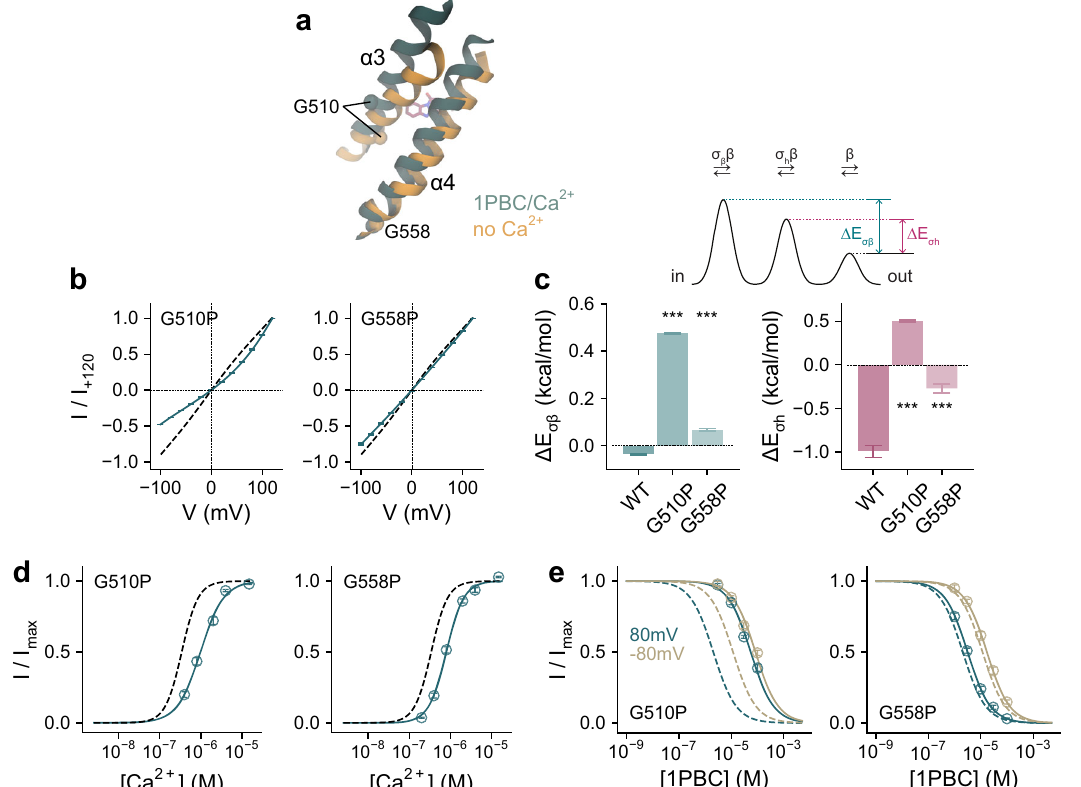
Fig. 8 Functional characterization of conformational changes. a Section of the pore in the superposed 1PBC/Ca 2 + -bound and the rebuilt Ca 2 + -free apo structures viewed from within the membrane. Spheres show C α of Gly 510 and Gly 558 on α 3 and α 4 respectively. b Instantaneous current-voltage relations of the indicated mutants at a saturating Ca 2 + concentration (15 and 50 µ M respectively). Data are averages of 5 and 6 biological replicates for G510P and G558P respectively, errors are SEM. Solid lines are fi ts of the averaged data to a model of ion permeation as described previously (Eq. 2) 23 . Dashed line is the relation of WT. c Energy barrier relative to the outermost barrier in the ion conduction path at the inner pore and the narrow neck region for the indicated mutants (Eq. 3 and see “ Methods ” ). Bars indicate the best- fi t values obtained via the fi ts shown in ( b ), errors are 95% CI. Inset, minimal ion permeation model illustrating the quantities plotted in ( c ). Asterisks indicate signi fi cant difference in a non-adjusted two-sided t -test (left, G510P, *** p = 0 and G558P, *** p = 3e − 12; right, G510P, *** p = 2e − 13 and G558P, *** p = 1e − 14, each compared to WT). d Ca 2 + concentration-response relation of the indicated mutants at 80 mV. Data are averages of 7 biological replicates for both G510P and G558P, errors are SEM. Solid lines are fi ts to the Hill equation. Dashed line shows the relation of WT. e Concentration-response relations of 1PBC of the indicated mutants at a saturating Ca 2 + concentration (15 µ M) at − 80 and 80 mV. Data are averages of 9 and 8 biological replicates for G510P and G558P respectively, errors are SEM. Solid lines are fi ts to the Hill equation. Dashed lines are the relations of